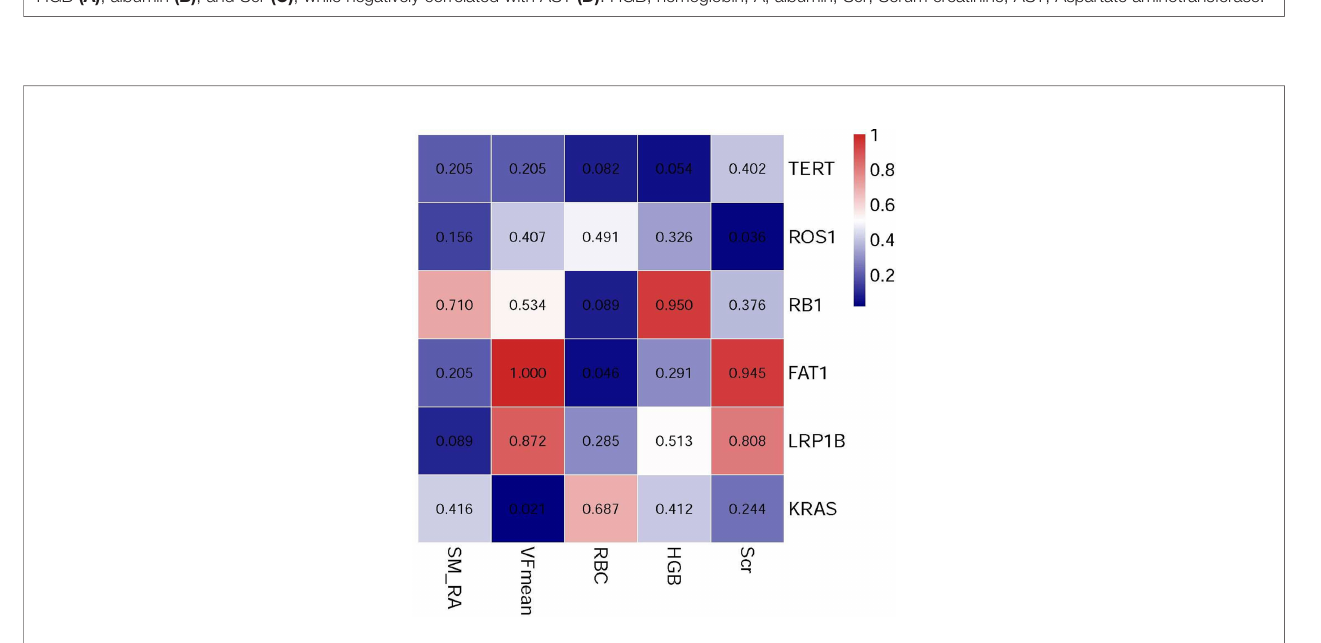
FIGURE 6 | Associations between the SM-RA and clinical parameters (HGB, albumin, Scr, AST). Scatter plots demonstrate that SM-RA is positively associated with HGB (A) , albumin (B) , and Scr (C) , while negatively correlated with AST (D) . HGB, hemoglobin; A, albumin; Scr, Serum creatinine; AST, Aspartate aminotransferase.